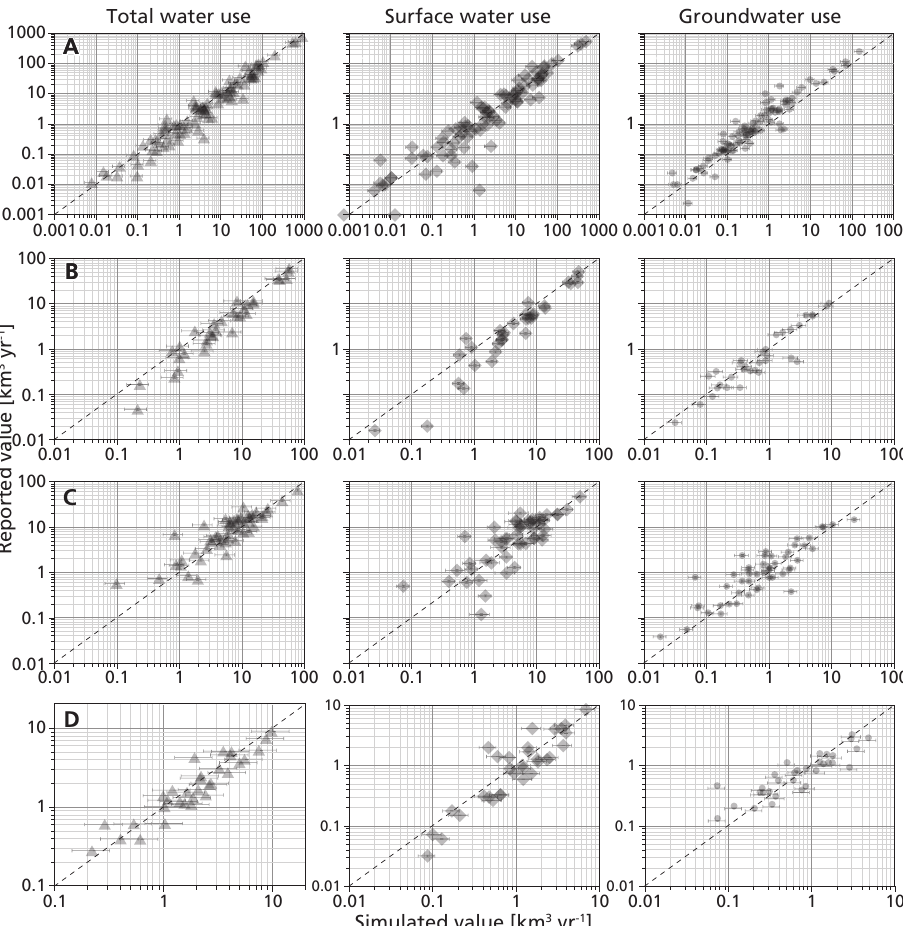
Fig. 3. Comparison of simulated total water withdrawals and water withdrawals per water source (surface water and groundwater) to reported values [km 3 yr − 1 ] for the year 2005 over (a) the globe per country ( N = 100), (b) Europe per country ( N = 34), (c) the USA per state ( N = 50), and (d) Mexico per state ( N = 32) in log-log plots. Simulated water use at 0.5 ◦ was spatially aggregated to country and state. Simulated value indicates the mean of the simulation with the ERA-Interim and MERRA climate. Error bars show standard deviation ( σ) among the simulation with the ERA-Interim and MERRA climate. The dashed lines represent the 1:1 line. The reported water withdrawal per source was obtained from the FAO AQUASTAT database for the globe, from the Eurostat database (http://epp.eurostat.ec.europa.eu/ portal/page/portal/environment/data/database) for Europe, from the US Geological Survey (Water Use in the United States; http://water.usgs. gov/watuse/ ) for the USA, and from the CONAGUA (Statistics on Water in Mexico; http://www.conagua.gob.mx/english07/publications/ Statistics_Water_Mexico_2008.pdf) for